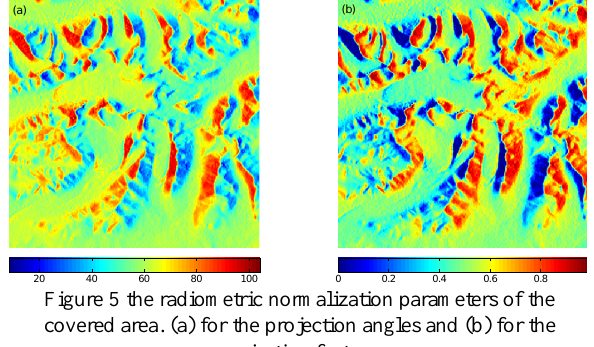
100 Figure 5 the radiometric normalization parameters of the covered area. (a) for the projection angles and (b) for the projection factors.